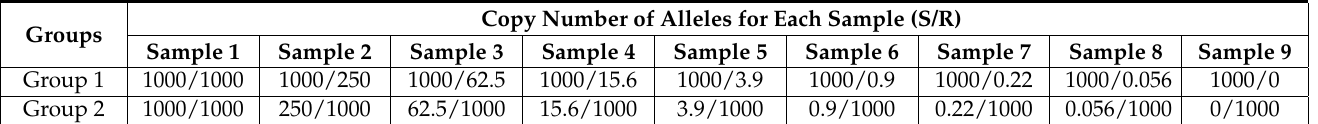
Table 2. Composition of mixed DNA samples. In group 1, nine samples were obtained by mixing 1000 copies of the G143 allele (S) with the serial dilution of copies of the A143 allele (R). Group 2 sam- ples were composed to be the opposite of Group